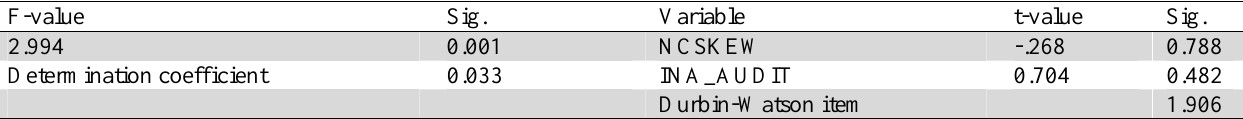
Third sub-hypothesis test results F-value Sig. Determination